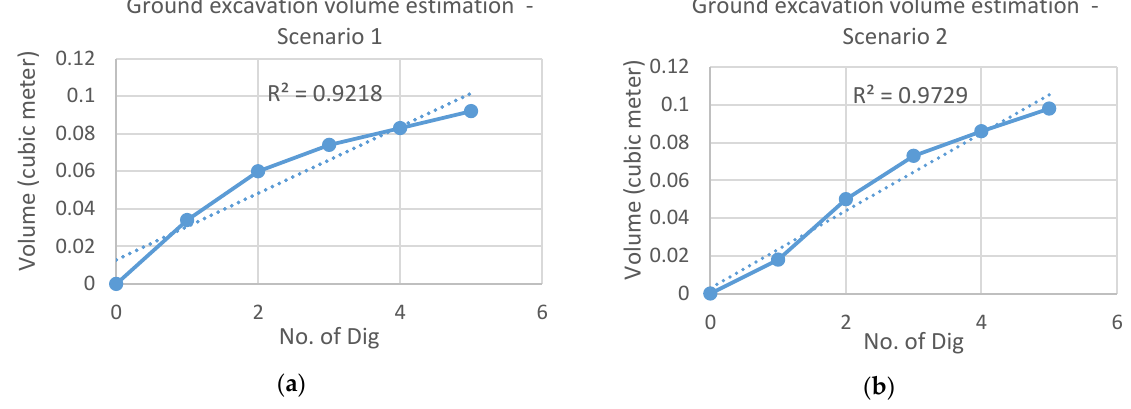
Figure 16. Point cloud of the ground surface after the 5th dig for the 1st scenario. The same scenarios considered in the bucket volume estimation were applied for the ground volume estimation. Below (Figure 17) are the two graphs that show the ground excavation volume estimation of each dig under the two scenarios.